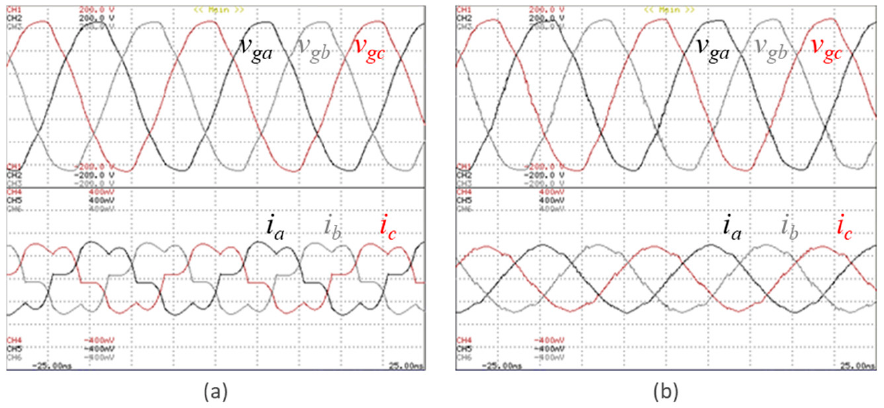
Figure 13. Experimental validation showing a result that validates the operation of the unified topology, compensating almost all harmonic currents (( a ) before and ( b ) after compensation) to contribute to compensate power quality problems on the power grid side: Power grid voltages ( v ga , v gb , v gc ) and currents ( i ga , i gb , i gc